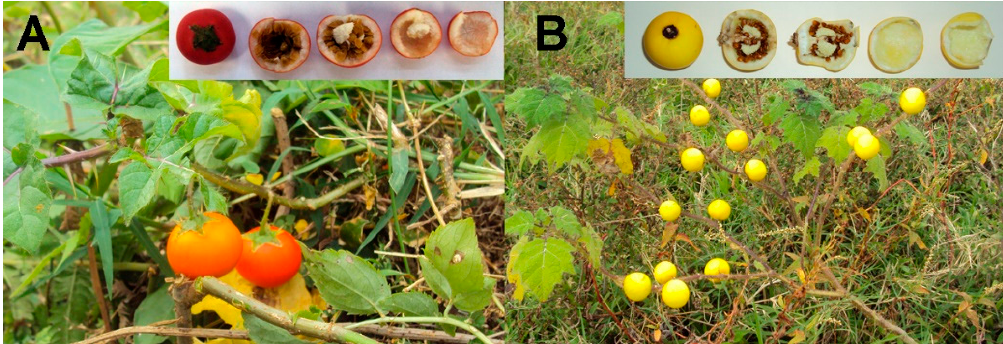
Figure 1. Photographs of the plants and fruits of ( A ) S. aculeatissimum Jacq, and ( B ) S. myriacanthum